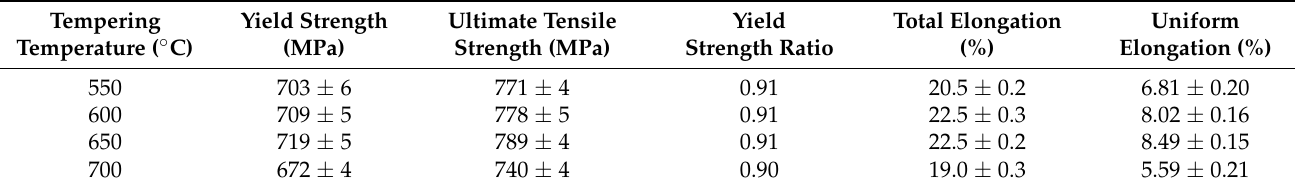
Table 3. Mechanical properties of studied steel after different tempering treatments.